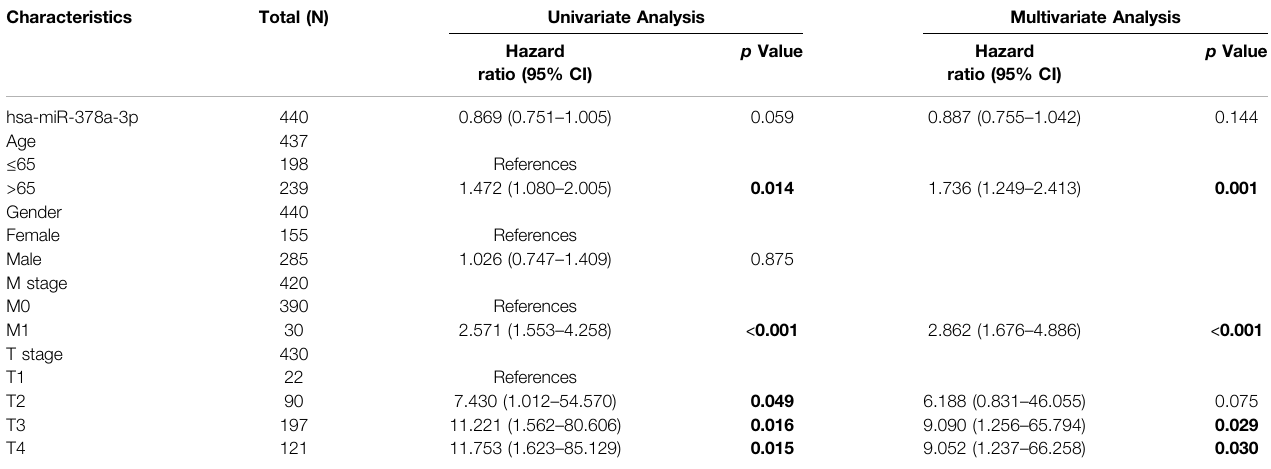
TABLE 3 | Univariate and multivariate Cox analysis of clinical variables and miR-378a-3p. Characteristics